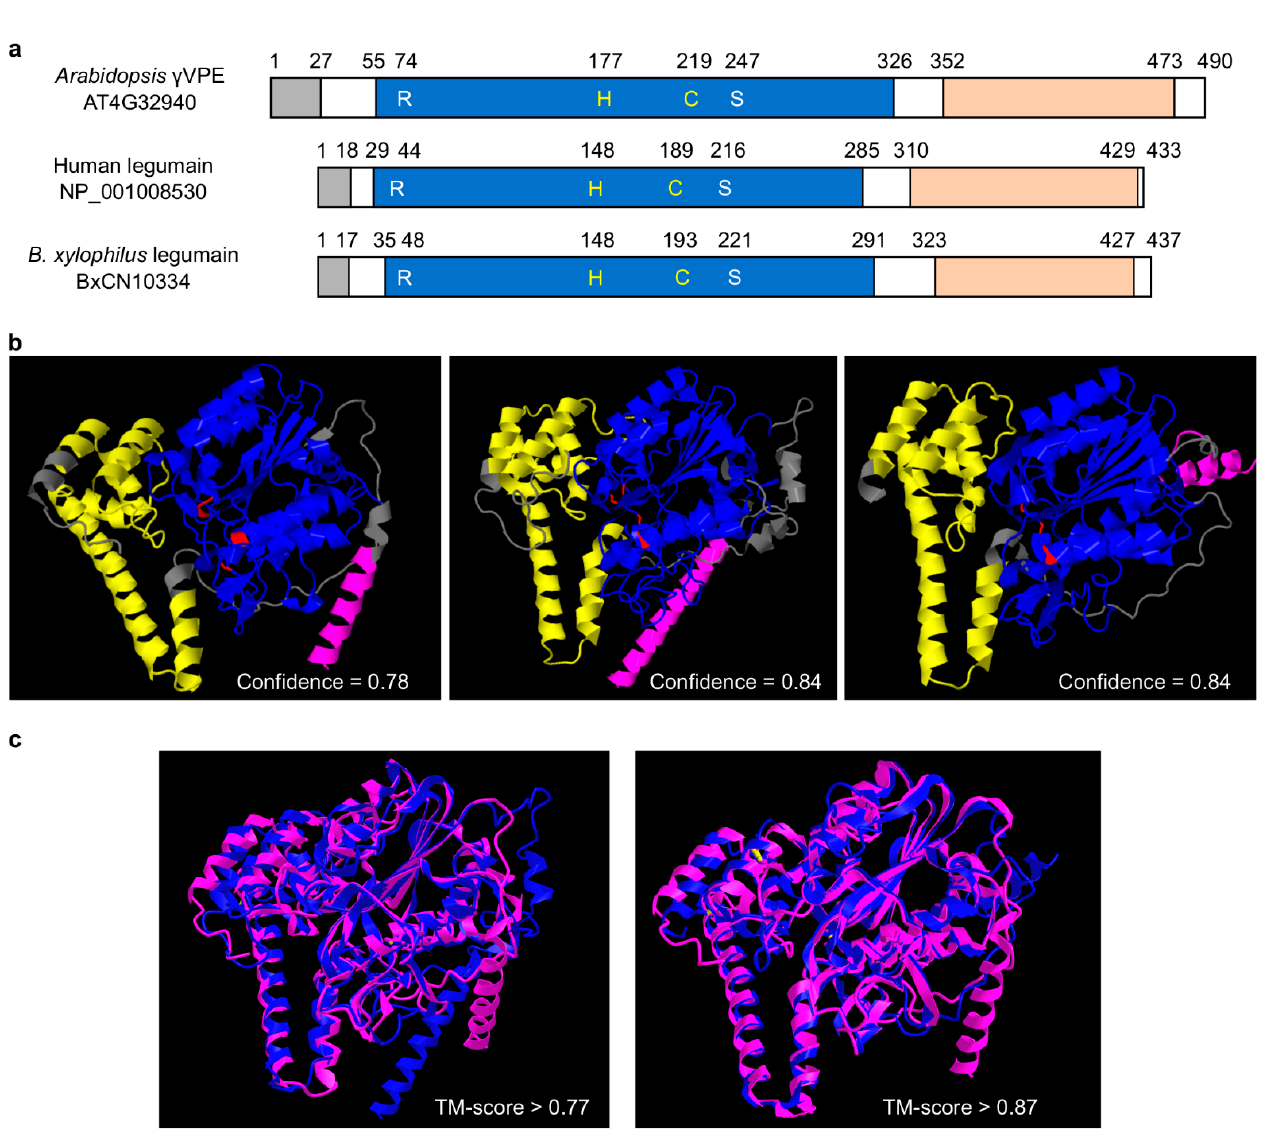
Figure 3. Structural comparison of legumains: ( a ) primary protein structural organization of B. xylophilus -specific legumain (BxCN10334), Arabidopsis γ VPE (AT4G32940), and human AEP (NP_001008530). They have a signal peptide (gray box) at the N-terminus, a peptidase_C13 domain (PF01650) (blue box) and a C-terminal prodomain of legumain (legumain_C, cd2115) (orange box). The C13 domain includes four essential amino acid residues (R, H, C, S), which form the substrate pocket, and the middle two (H, C) are catalytic dyad; ( b ) prediction of spatial structures of B. xylophilus -specific legumain, Arabidopsis γ VPE, and human AEP, with RoseTTAFold online (job IDs 207107, 207108 and 207109, respectively). Pink: signal peptide; blue: peptidase C13 family domain; yellow: C-terminal of prodomain of legumain; red: the essential amino acid residues; ( c ) protein structure comparison by TM-align, between B. xylophilus legumain and Arabidopsis γ VPE, B. xylophilus legumain and human AEP. Pink represent B. xylophilus legumain, blue represent Arabidopsis γ VPE or human AEP.